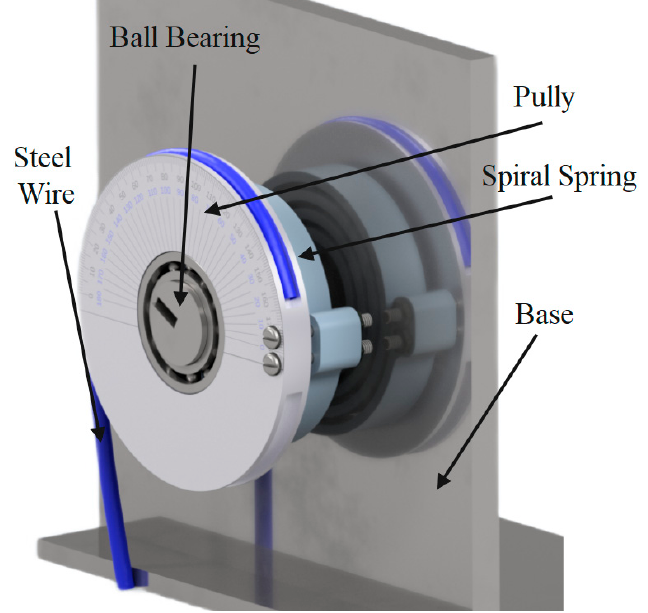
Figure 16. 3D rendering of the test reg.